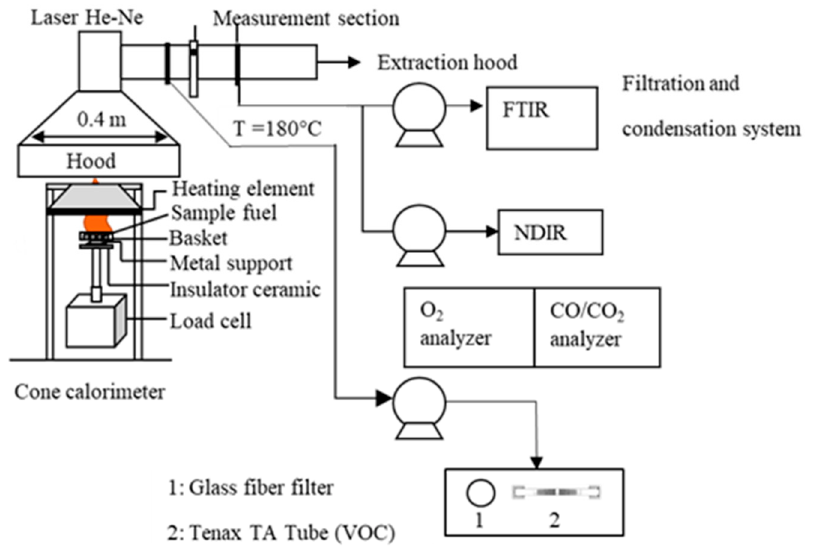
Figure 1. Schematic of the cone calorimeter and analysers for determining the sampled gas, VOCs and aerosols.